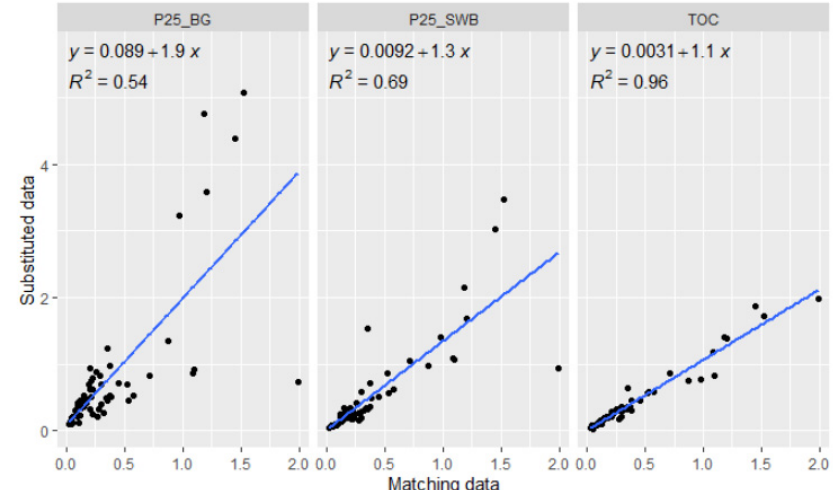
Figure 5. The comparison of the M-BAT calculated RCR for Cu between the matching data and substituted data (P25_BG—the 25th percentile of the available DOC data and/or the DOC data calculated by the TOC from the Bulgarian monitoring network results during 2020; P25_SWB—the 25th percentile of the DOC data calculated by the TOC for the respective water body; TOC—the matching DOC data calculated by TOC).